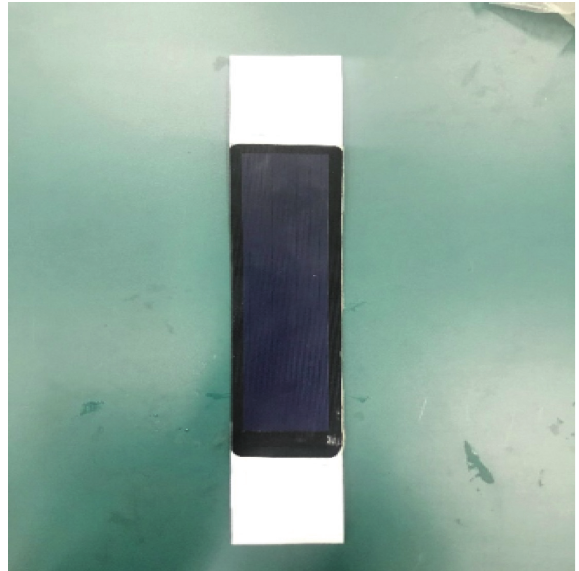
Figure 1: PV-PVC composite specimen.